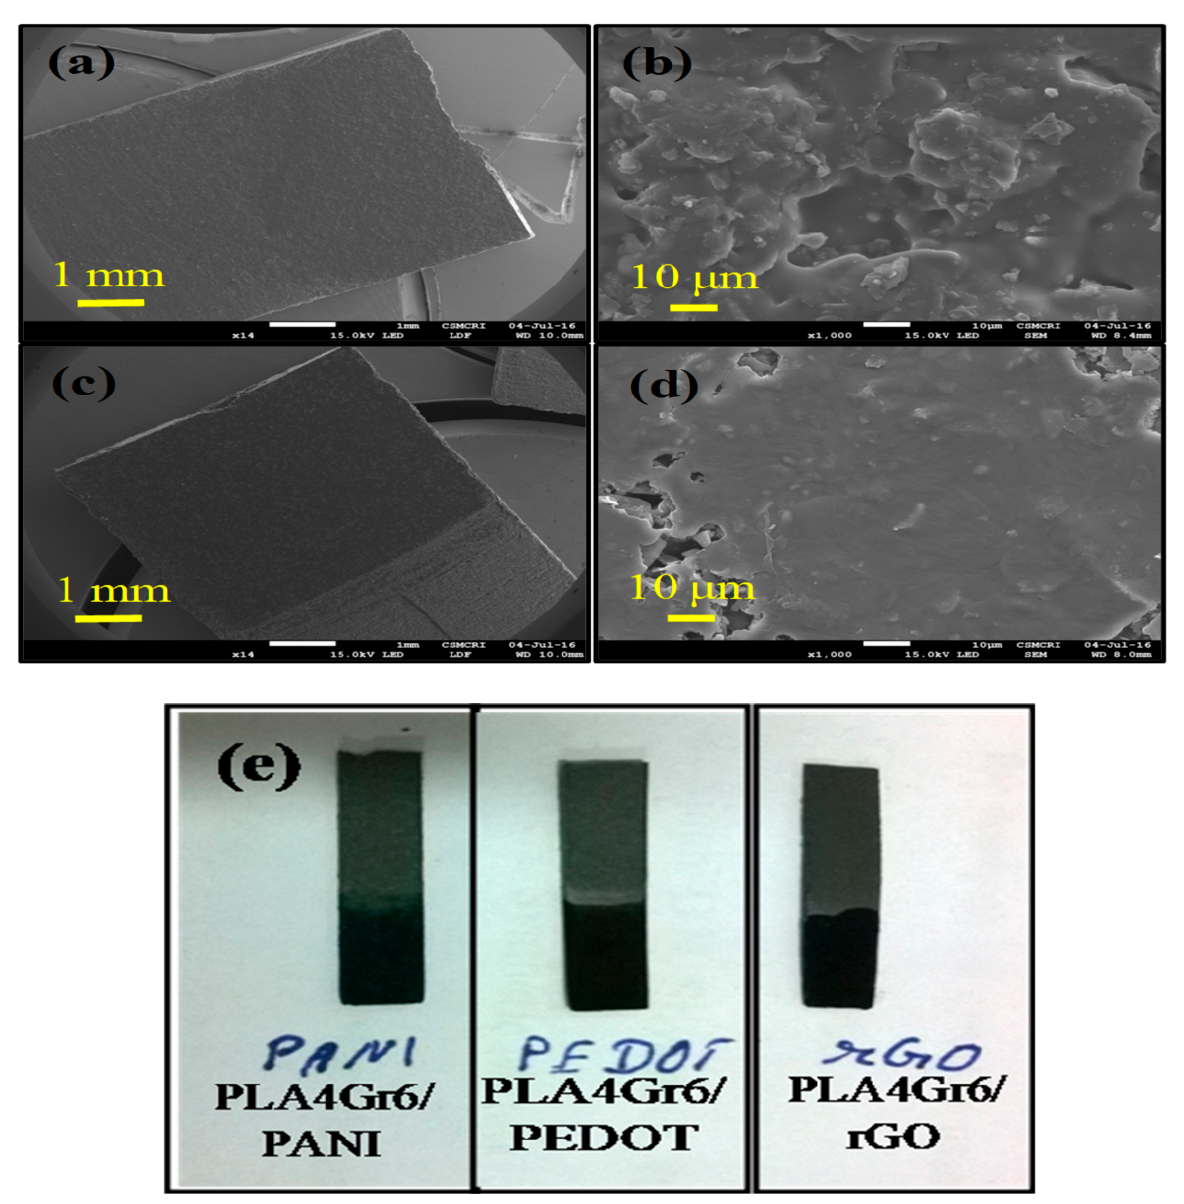
Figure 3. SEM images of conducting polymers coated on PLA4Gr6 Electrodes ( a , b ) PANI coated electrodes; ( c , d ) PEDOT coated electrode; ( e ) Photographs of coated electrodes.